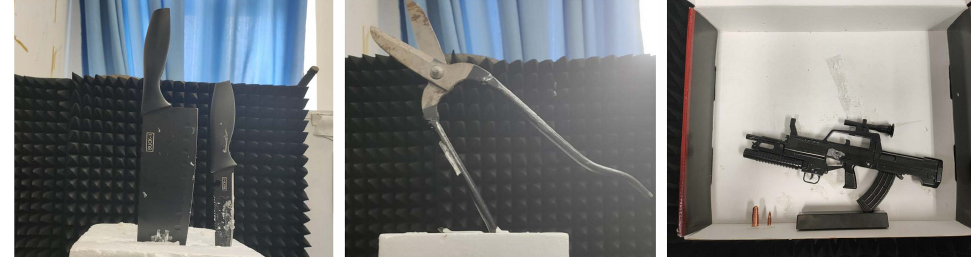
Figure 11. The optical images. Left is knife and stiletto; Middle is a snips; Right is a concealed